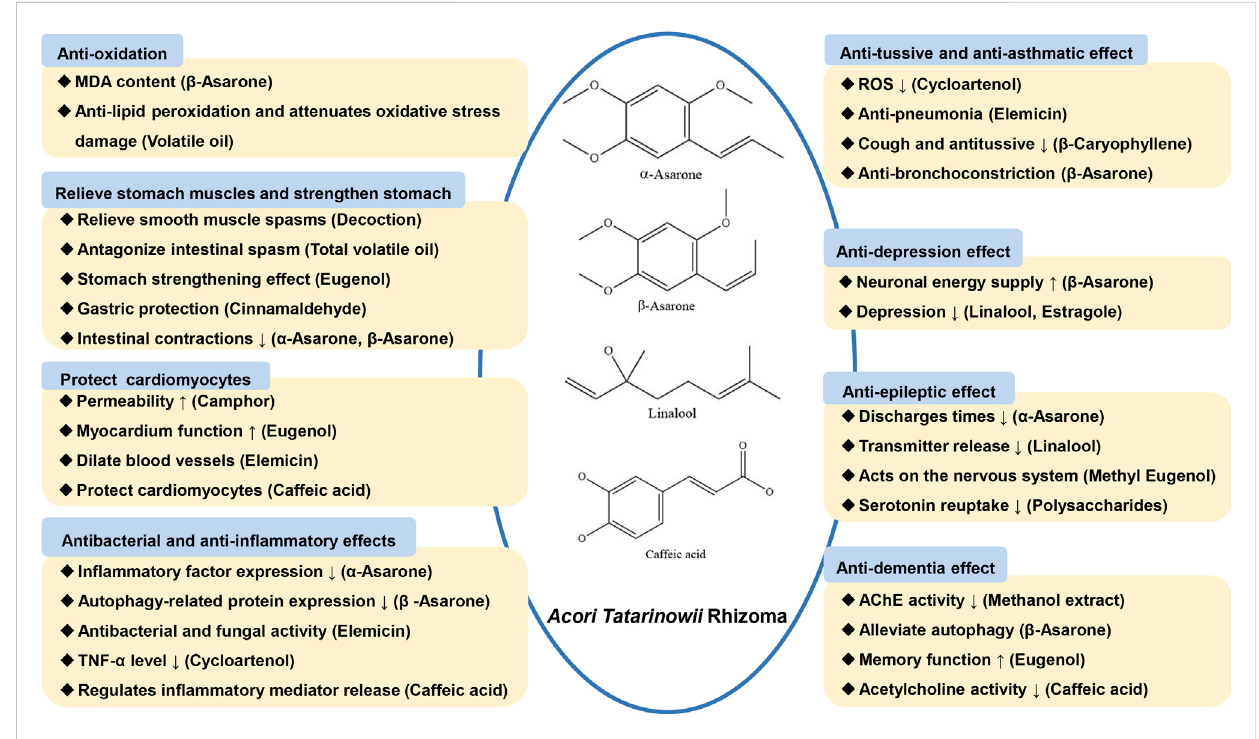
FIGURE 3 Active chemical constituents and pharmacological mechanism of